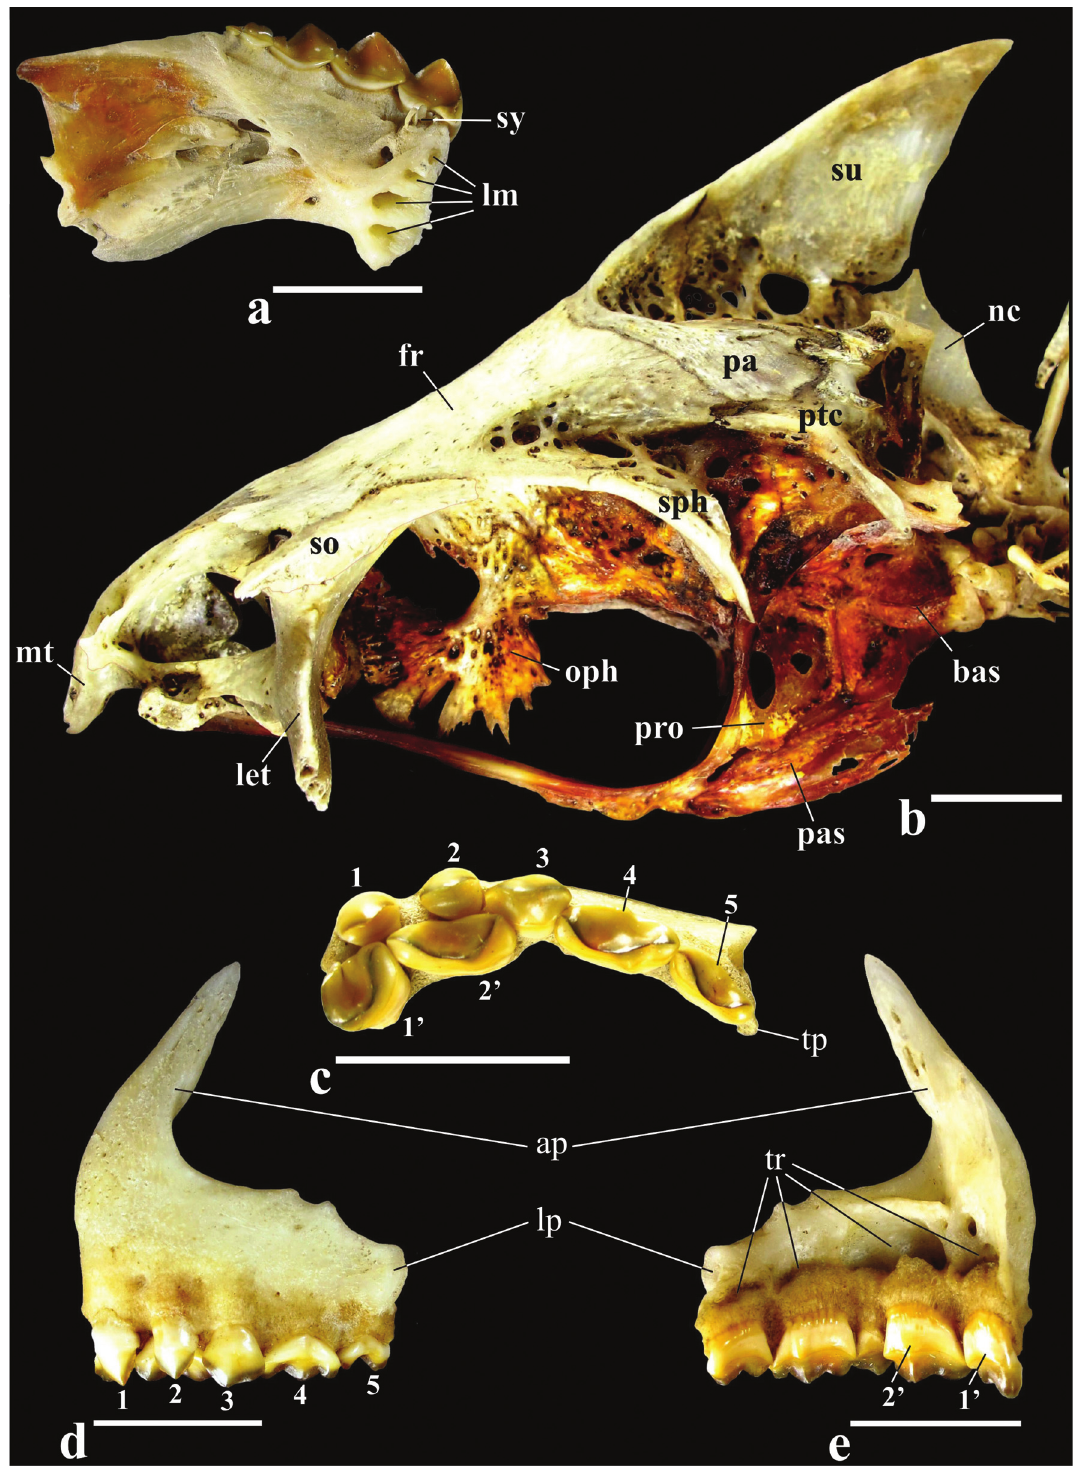
Fig. 2. Tometes camunani , MPEG 23448, 382 mm SL. a , lingual view of left dentary. b , lateral view of the neurocranium. c-e , ventral, labial and lingual views of the left premaxilla (1-5: teeth in labial row; 1’-2’: teeth in lingual row). ap = ascending process of premaxilla; bas = basioccipital; fr = frontal; let = lateral ethmoid wing; lm = lamellae at symphysis; lp = lateral process of premaxilla; mt = mesethmoid; nc = neural complex; oph = orbitosphenoid; pa = parietal; pas = parasphenoid; pro = prootic; ptc = pterotic; su = supraoccipital; so = supraorbital; sph = sphenotic; sy = position of symphyseal tooth; tp = transversal process; tr = replacement teeth trenches. Scale bar: 10